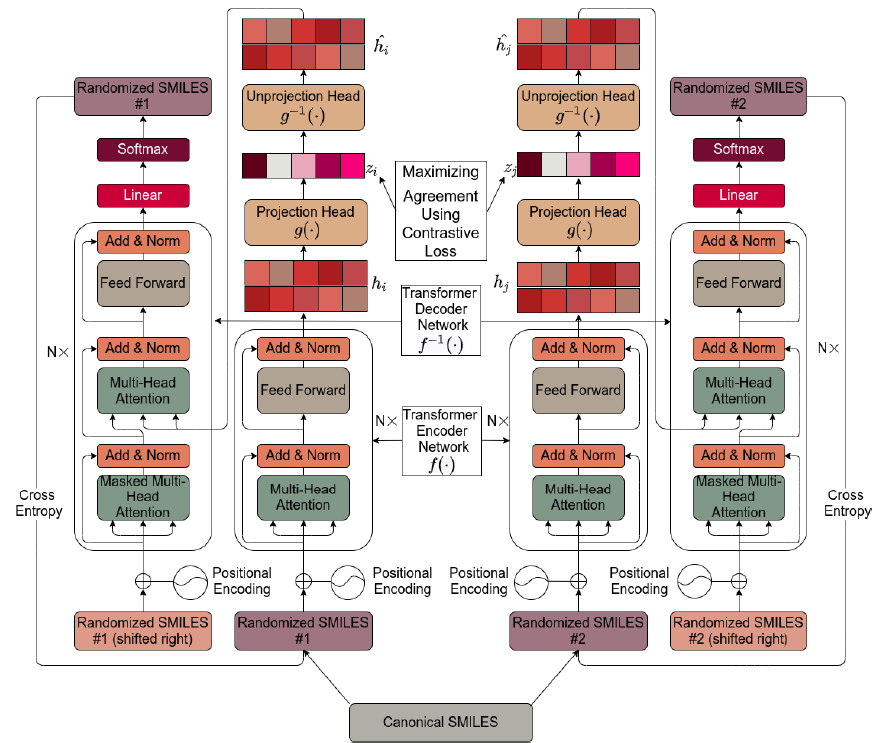
Figure 1. The transformer-based architecture used in the present work. The internals are described in Section 4. Scheme 1. Pseudocode for the transformer algorithm as implemented here.